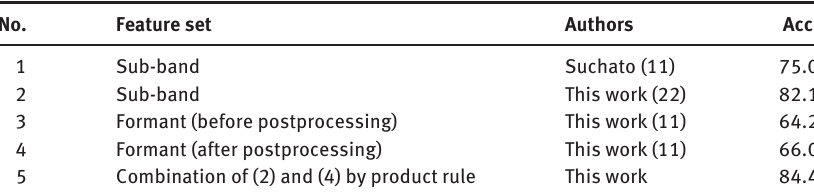
Table 4. Classification Accuracy (%) Obtained by Different Feature Sets Derived in this Work.